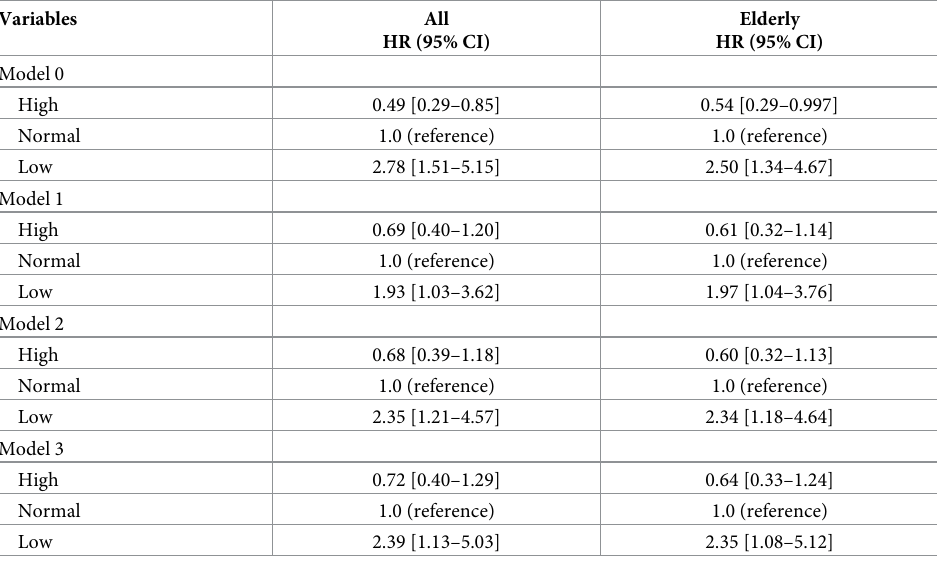
Table 3. Hazard ratio of BMI category by multivariate Cox regression analysis for all-cause mortality in all HD patients and elderly ( � 65 years) HD patients at the first HD